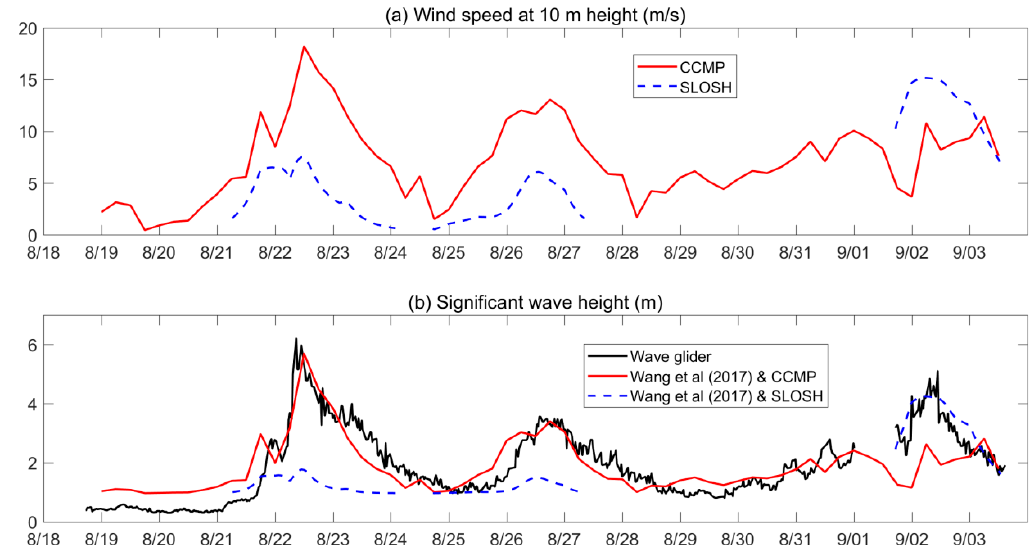
Figure 10. ( a ) Wind speed at 10 m height using Cross-Calibrated Multi-Platform (CCMP) data (solid red) and the Sea, Lake, and Overland Surges from Hurricanes (SLOSH) scheme (dash blue). ( b ) Significant wave height from the wave glider (solid black), the parameterization of Wang C. et al. (2017) [57] by using CCMP wind (solid red), and the parameterization of Wang C. et al. (2017) by using SLOSH wind (dash blue).